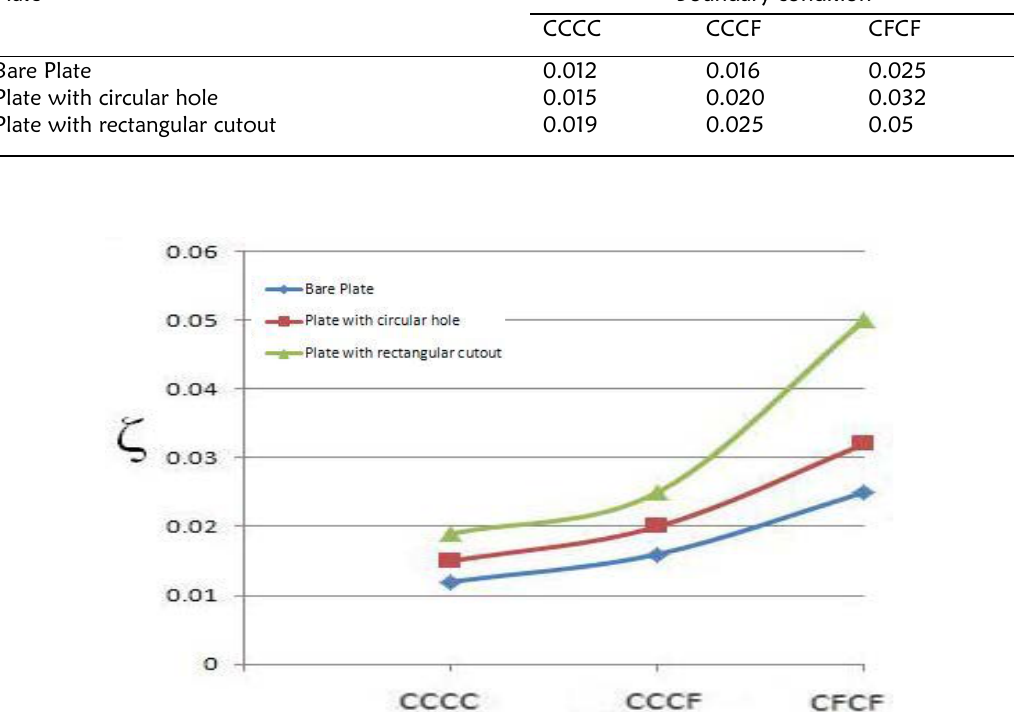
Figure 9: Comparison of damping factor of various composite